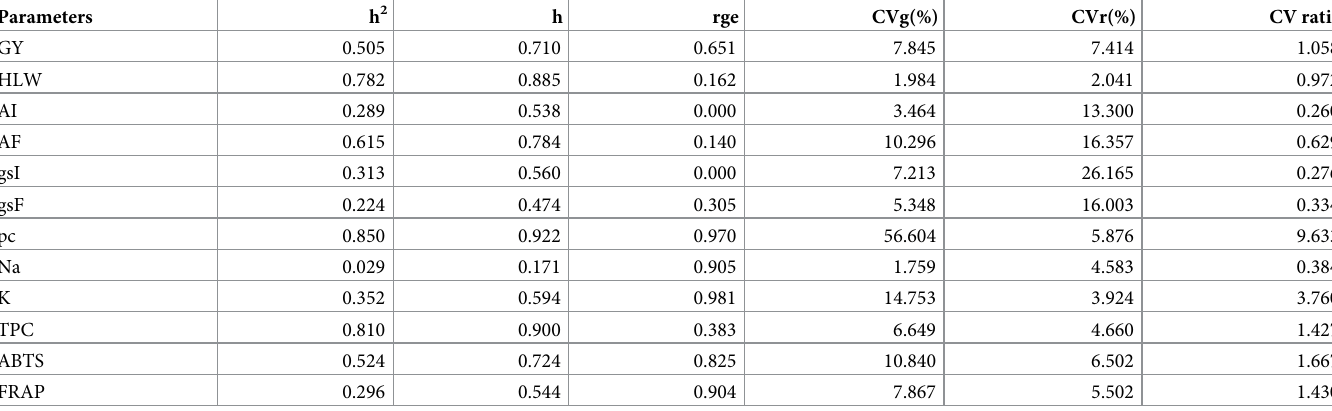
Table 2. - Phenotypic variance, broad-sense and genotype mean basis (h 2 ) heritability, accuracy of selection (h), genotype-environment correlation (rge), genotypic (CVg) and residual (CVr) coefficient of variation, and CVg/CVr ratio.